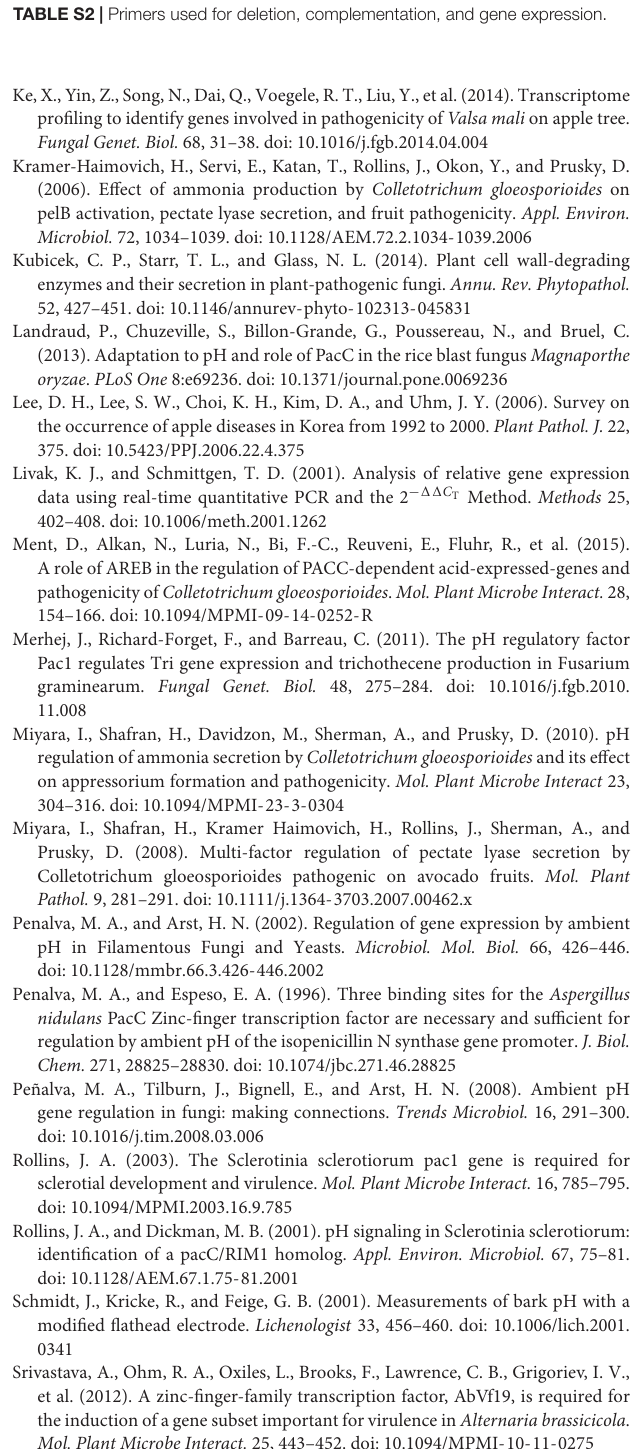
FIGURE S3 | Construction of dominant activated mutant of VmPacC27 . (A) Prediction of activated sequence with A. nidulans . (B) PCR detection of positive